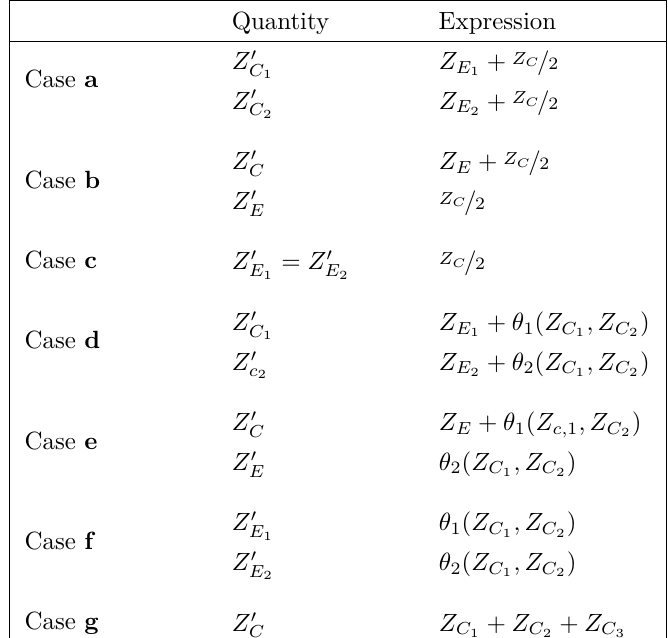
Table 3. Relations between Z X and Z 0